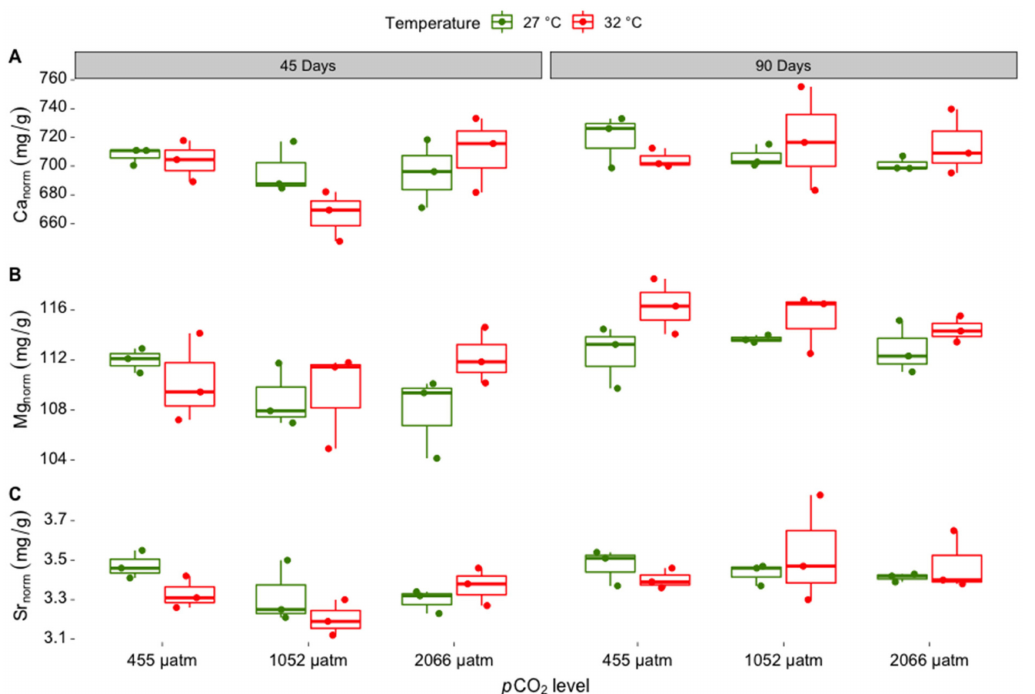
Figure 2. Ratios between skeletal mineral element to total skeletal material ( A ) Ca norm ratios (mg/g), ( B ) Mg norm ratios (mg/g), and ( C ) Sr norm ratios (mg/g) in A. yairi exposed to elevated temperatures levels (27 ◦ C and 32 ◦ C) crossed with increased p CO 2 concentrations (455 µ atm, 1052 µ atm and 2066 µ atm) measured after 45 and 90 days of incubation ( n = 36). Dots represent individual skeletal mineral values, displayed with jitter to avoid